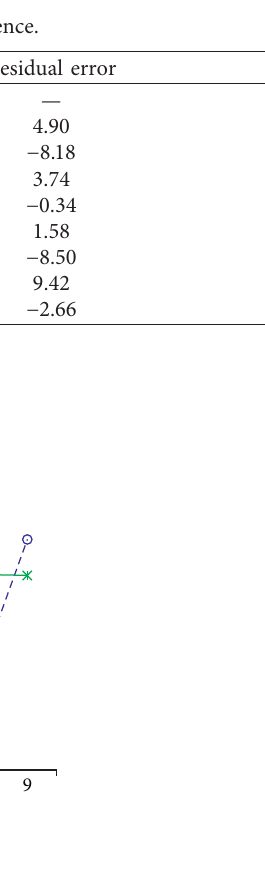
Figure 4: The GM (1, 1) fitted value of original